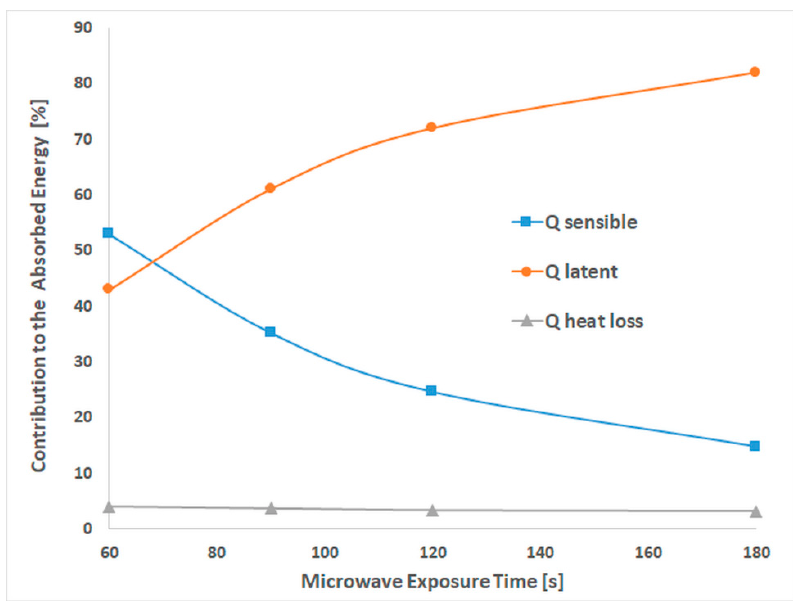
Figure 1. Contribution to the absorbed energy of the heat components versus MW exposure time.